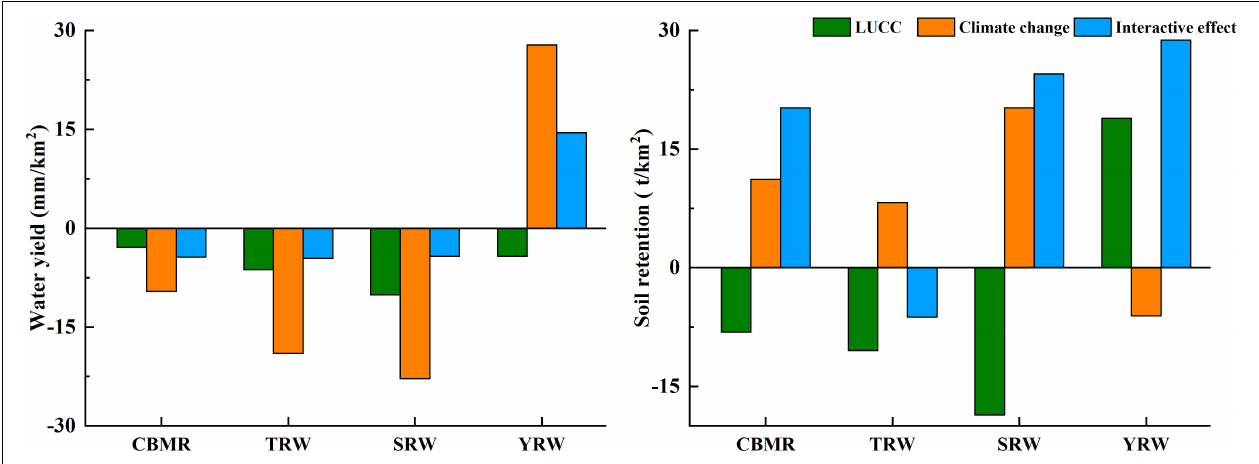
FIGURE 6 | The effect sizes of climate change, land use/cover change (LUCC) and their interaction on changes in water yield and soil retention during 2020–2050s for the Changbai mountains region (CBMR) and three watersheds.